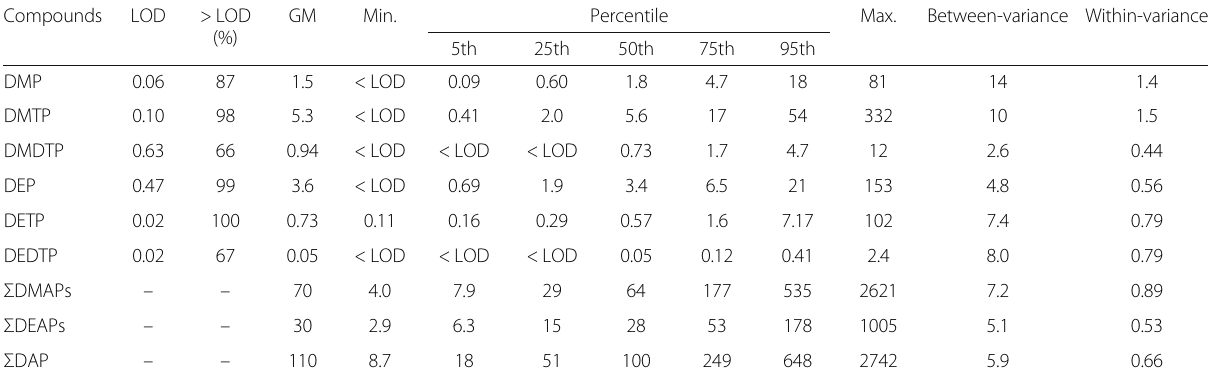
Table 1 Limit of detection, detection rates, geometric means, and percentile values of urinary dialkylphosphate concentrations among pregnant women in Japan Compounds